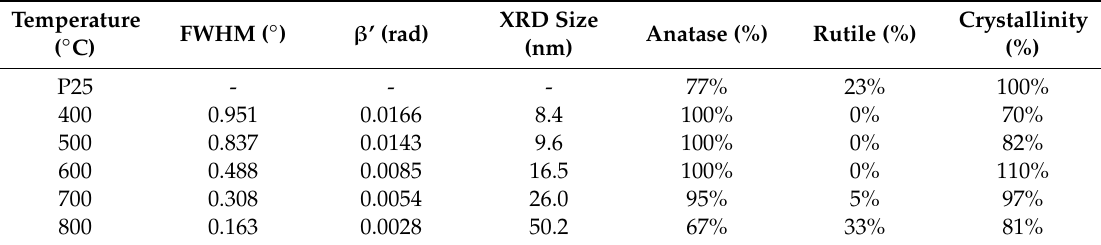
Table 1. Size of nano-TiO 2 and crystallinity calculated by XRD ( X-ray diffraction ). Temperature